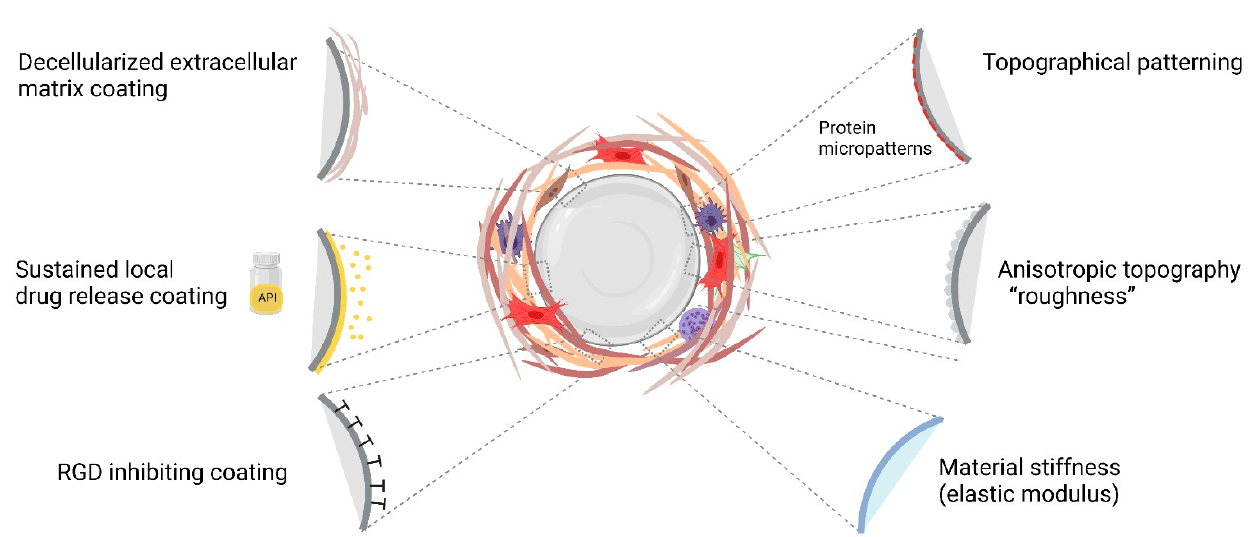
Figure 2. Modulating implant surface properties is a common strategy to enhance tissue integration while simultaneously reducing the incidence and severity of implant FBR and fibrosis. Protein coverage and cell interactions with the surface both determine the ability of cells to attach and spread on implants. Various physical and chemical modifications to the Implants surface are used to inhibit FBR. ( A ) Chemical modifications of surface properties include coating with local and slow releasing anti-fibrotic drugs to prevent implant fibrosis. In addition, subcutaneously implanted tissue expanders coated with decellularized ECM into non-human primates display minimal fibrotic. Inhibiting α v-integrin binding, e.g., with the RGD-peptidomimetic inhibitor CWHM-12 attenuate implant encapsulation by preventing mechanical activation of latent TGF- β 1 and myofibroblasts. ( B ) In addition to or combined with altering implant surface chemistry, other treatments include modulation of physical parameters such as surface hydrophilicity or wettability, porosity, stiffness (elastic modulus), anisotropic ‘roughness’, and regular topographies. Perceived stiffness and ‘true’ modulus of the implant sur ‐ face can be used to control cell responses. Restriction of focal adhesion sizes by micropatterning stiff surfaces with adhe ‐ sion sized fibronectin islets limits myofibroblast spreading, intracellular stress and α‐ SMA stress fiber incorporation. Mod ‐ ulating implant geometry (size, thickness, shape, and pore size) or coating with low fouling material such as zwitterions reduces protein adsorption to implant surfaces and reduces implant fibrosis. Scheme was prepared using Biorender. Surface charge has been shown to alter the efficacy of host protein adsorption to the implant. For example, the plasma proteins fibronectin and vitronectin possess a higher affinity for positively or negatively charged hydrophobic implant surfaces than to un ‐ charged hydrophobic surfaces [75–77]. Moreover, it has been suggested that macrophage rather adhere to hydrophobic and cationic implant surfaces than to hydrophilic and ani ‐ onic surfaces [3]. Likewise, providing implant materials with hydrophilic surfaces, for in ‐ stance by oxygen plasma treatment, generally improves cell adhesion and spreading, partly by facilitating the initial absorption of ECM proteins. As a result, basic cell functions such as proliferation, survival, and differentiation are enhanced [78–80]. Conversely, re ‐ ducing surface wettability of polyurethane, a material frequently used for medical de ‐ vices, by using zwitterionic and anionic chemistry decreases macrophage spreading areas which regulates their secretion of proinflammatory cytokines and ability to fuse into FBGCs [81]. Ultra ‐ low ‐ fouling zwitterionic hydrogels are also to prevent peri ‐ implant fi ‐ brosis, and promote wound healing and neovascularization in the adjacent tissue when subcutaneously implanted in a mouse model [43]. In addition to coating with zwitterions, non ‐ fouling hydrophilic PEG is another material that reduces protein adsorption to im ‐ plant surfaces [82,83]. Although one of the possible drawbacks of PEG is its susceptibility